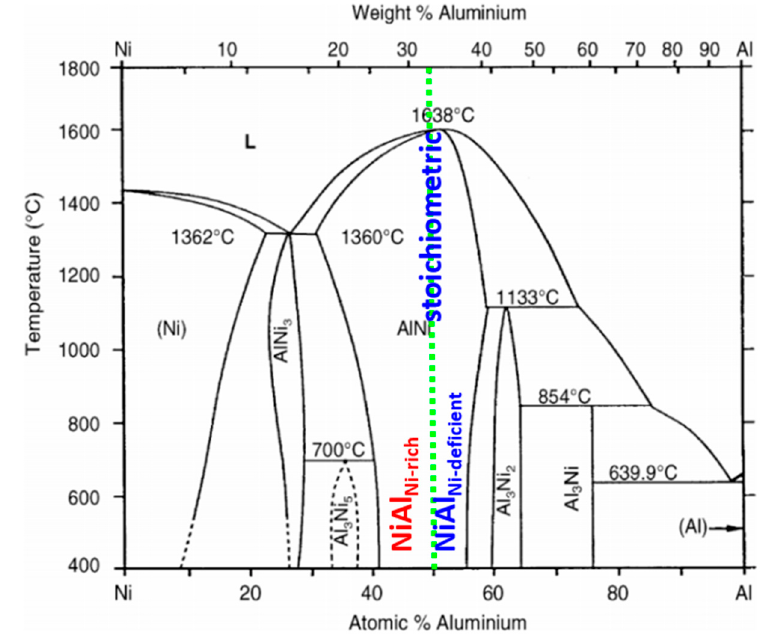
Figure 2. Equilibrium phases diagram Ni–Al with distinction between various types of the AlNi phase [25].